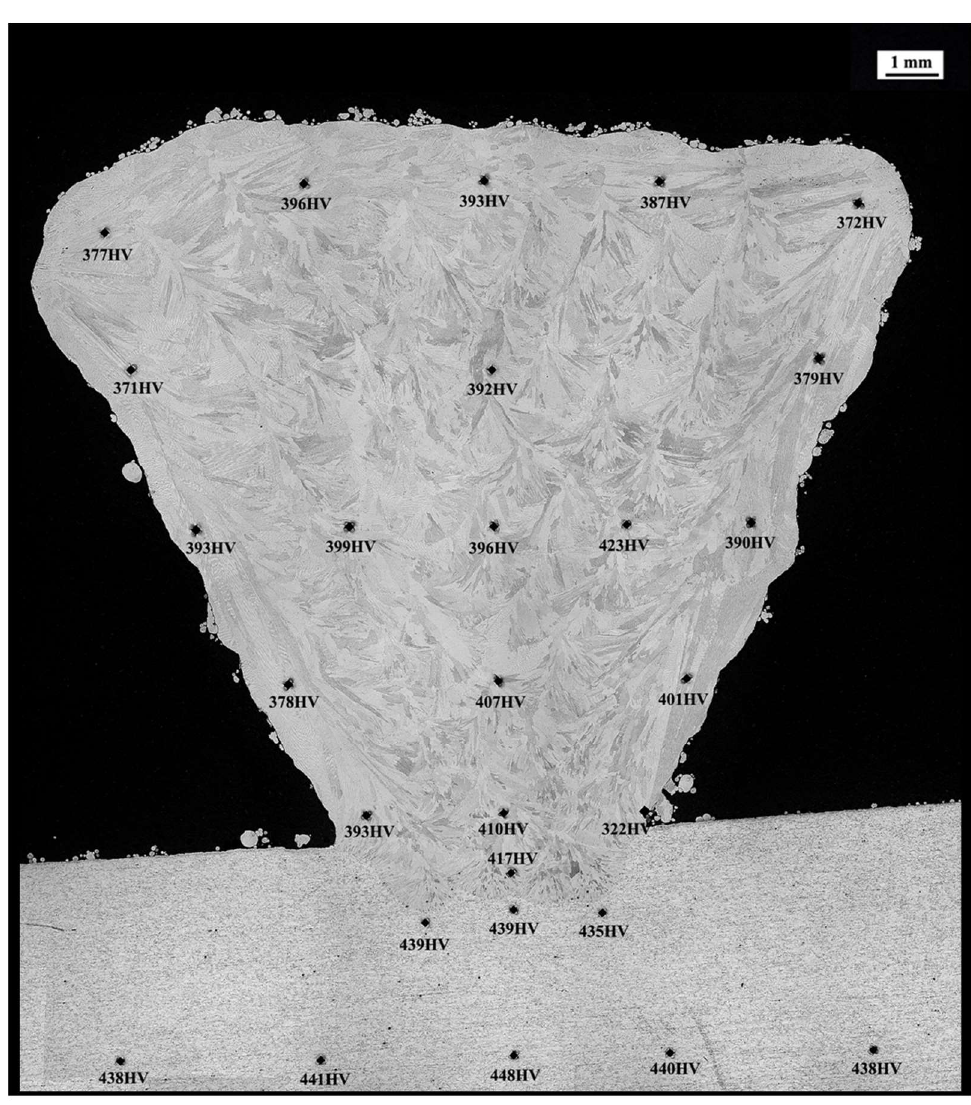
Figure 8. Hardness profile of the direct aged sample.